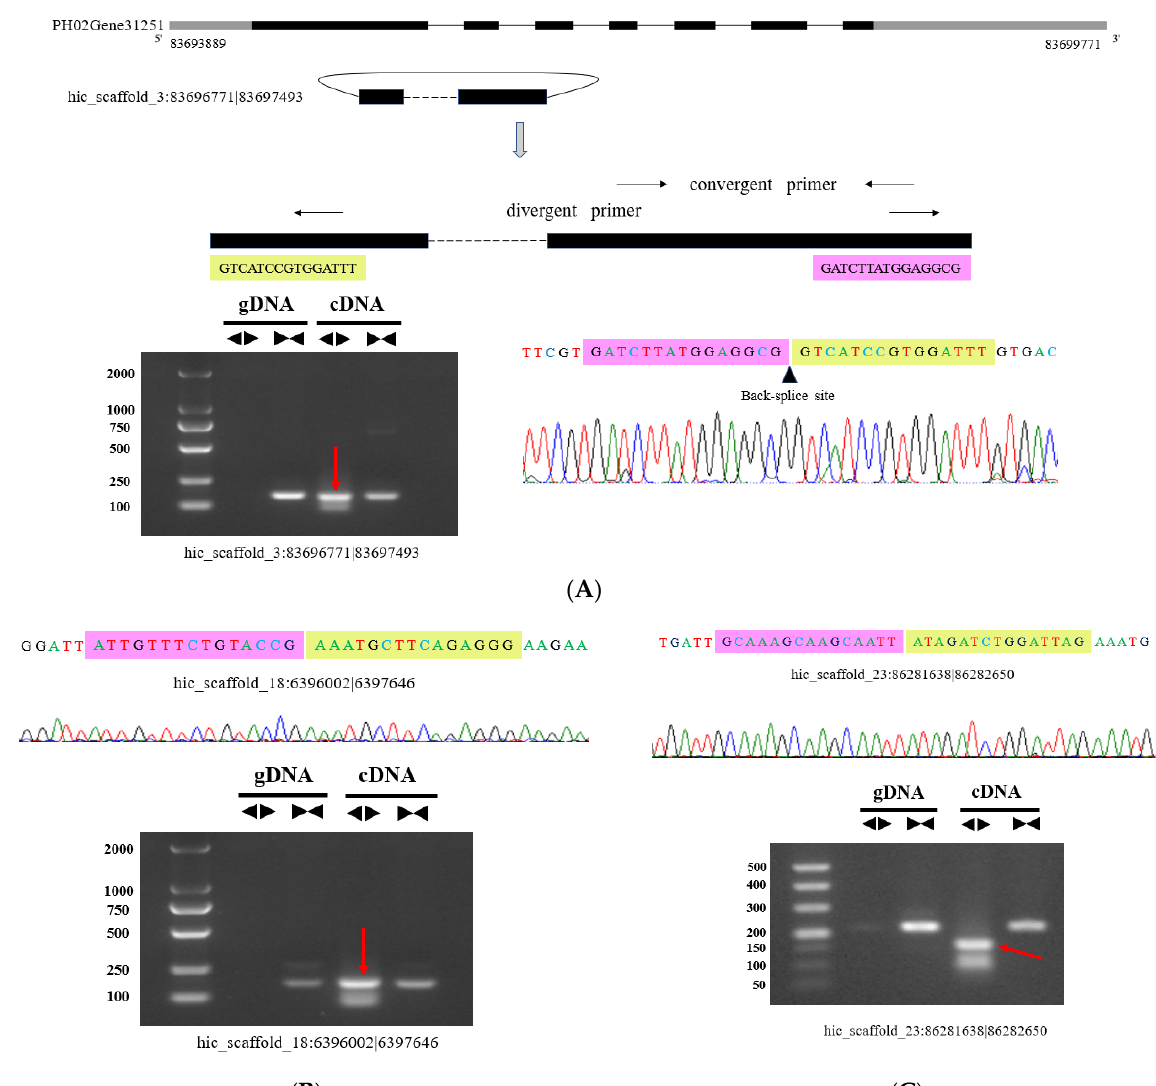
Figure 4. Validation of circRNAs by PCR and Sanger sequencing. ( A ) A circRNA (hic_scaffold_3:83696771|83697493) exemplifying the validation strategy. According to the genomic loci, circRNA hic_scaffold_3:83696771|83697493 was derived from the gene PH02Gene31251. The two sets of arrows indicate the two sets of amplification primers that were designed to confirm head-to-head reverse splicing by PCR and Sanger sequencing. ( B , C ) Validation of two circRNAs (hic_scaffold_18:6396002|6397646, hic_scaffold_23:86281638|86282650) by PCR and Sanger sequencing. Divergent primers successfully amplified the circRNAs in cDNA but not those in gDNA. Convergent primers amplified the circRNAs in both cDNA and gDNA.